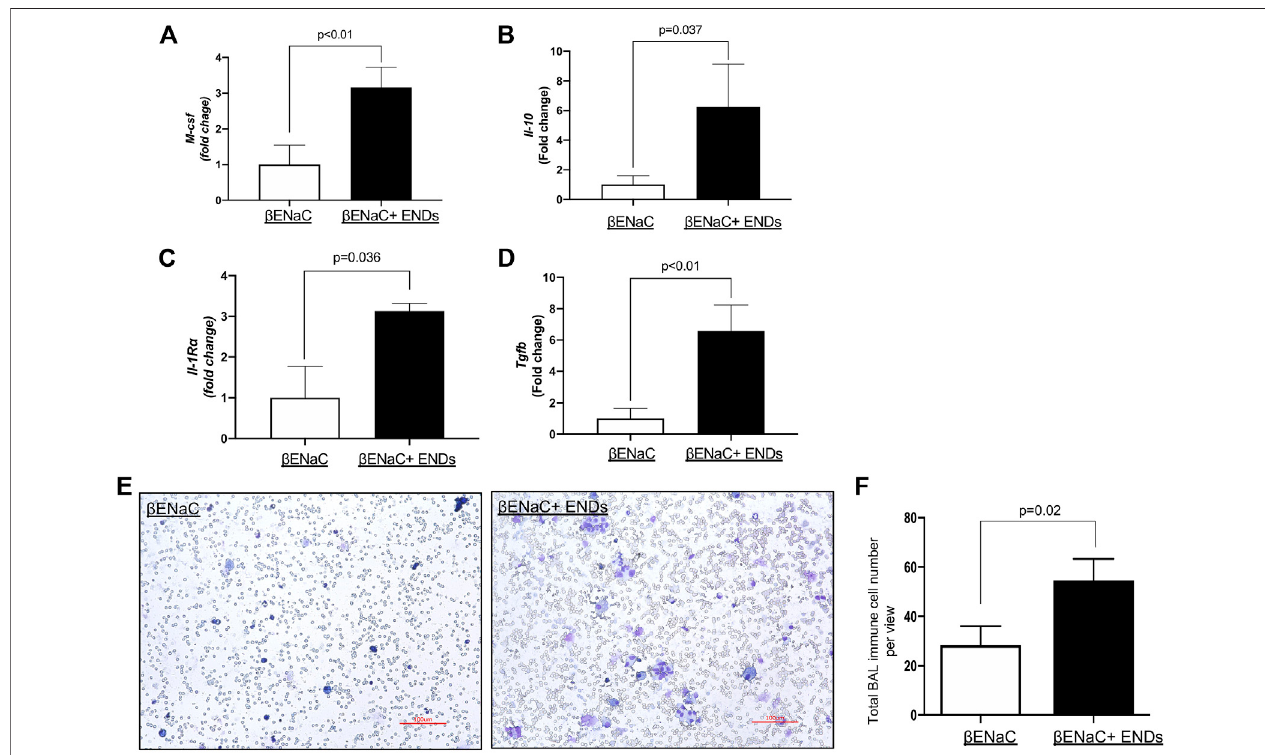
FIGURE2| E-cigaretteexposureelevatesin fl ammatoryresponse. (A – D) DeterminationofmRNAlevelsofin fl ammatorycytokinesinlungtissuesfrom β ENaCmice withorwithoutENDSexposureby qPCR. (E) Representativeimages ofDiff-Quik stainingofBALfrom β ENaCmice with orwithout ENDSexposure ( n (cid:1) 4per group). (F) Quanti fi cation of Diff-Quik staining as in (E) ( n (cid:1) 4 per group). All data presented at mean ±